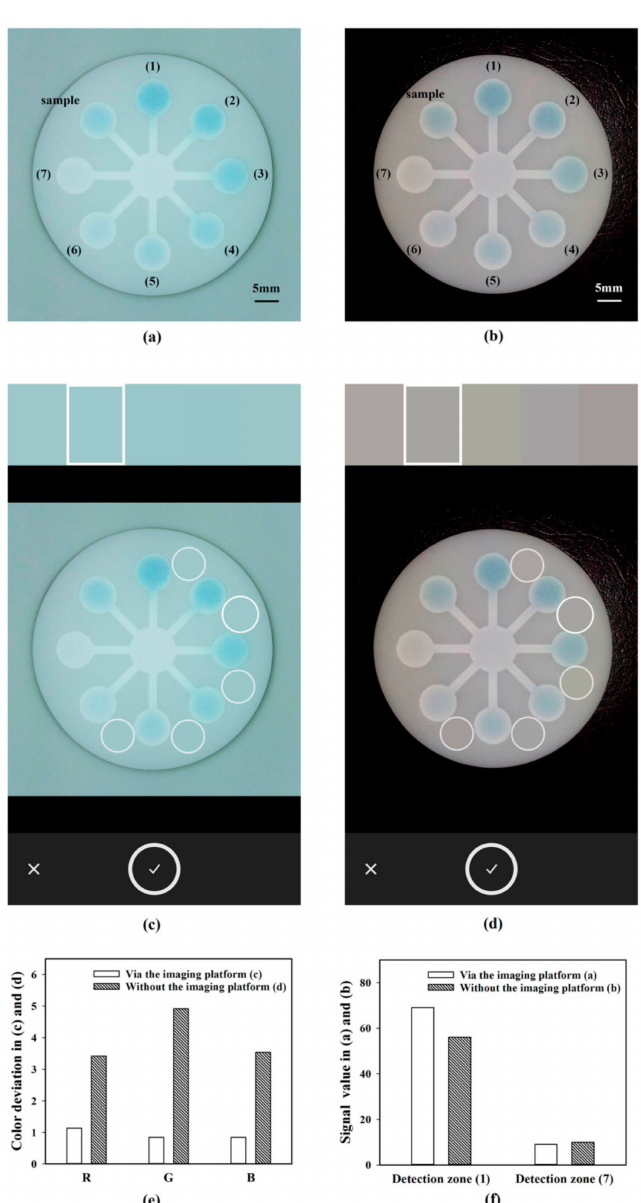
Figure 8. The image of the chromogenic chip captured via the imaging platform ( a ) and without the imaging platform ( b ). The uniformity of illumination in the imaging platform ( c ) and without the imaging platform ( d ) was investigated by analyzing the colors of the selected circles in Adobe Capture CC. ( e ) The color deviations of the selected circles in ( c , d ). ( f ) The R values of the first and seventh detection zones in ( a , b ). (For interpretation of the references to color in this figure legend, please refer to the web version of the